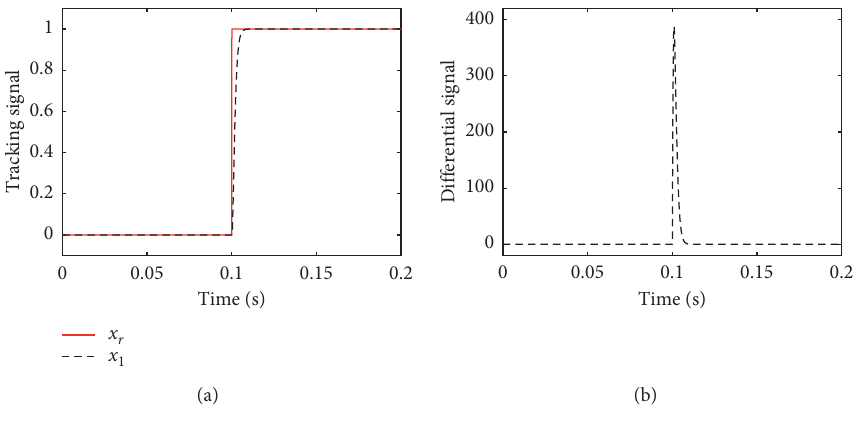
Figure 9: TD output results for step input.